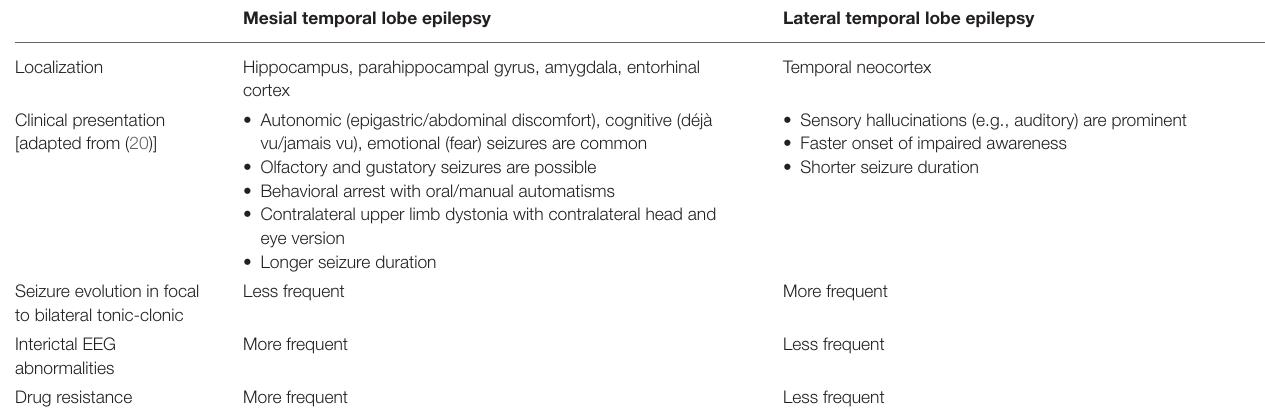
TABLE 1 | Differences between mesial and lateral temporal lobe epilepsy.